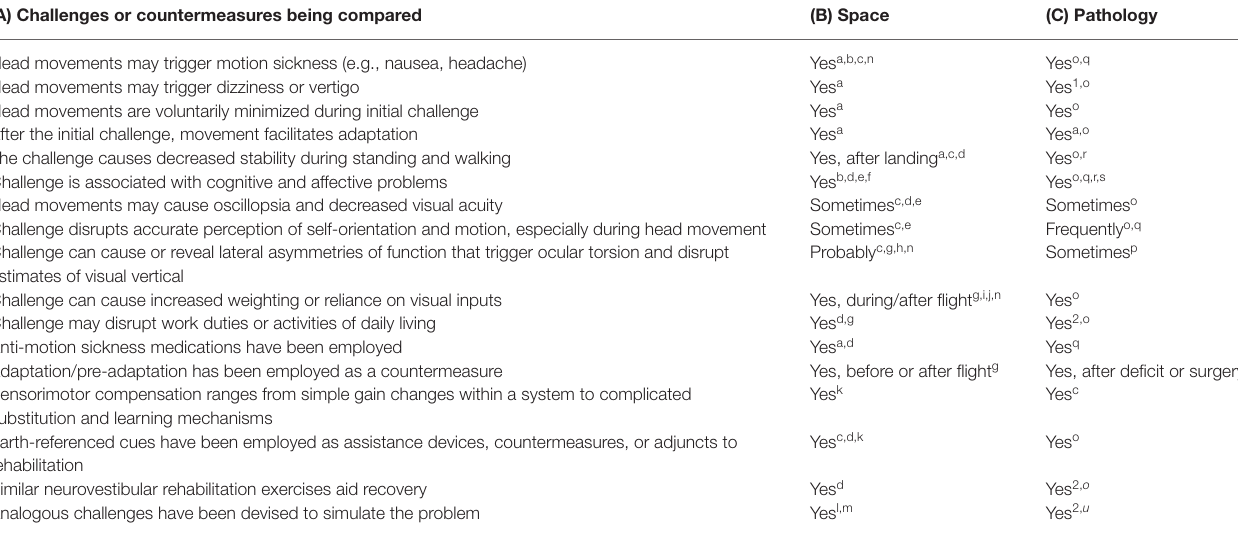
TABLE 1 | Comparison of neurovestibular challenges and countermeasures (Column A) associated with reactions to spaceflight (Column B) vs. vestibular pathology (Column C). (A) Challenges or countermeasures being compared (B) Space (C)